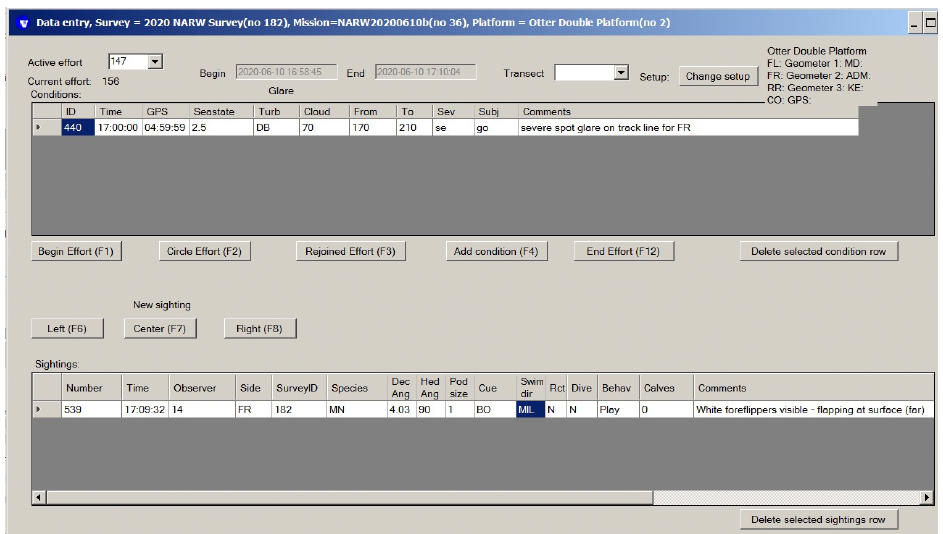
Figure 4. Visual Surveyor software data entry window, indicating several key features, including display of user-defined operation settings, observer positions, record of sighting conditions (top pane) and recorded sighting event (bottom